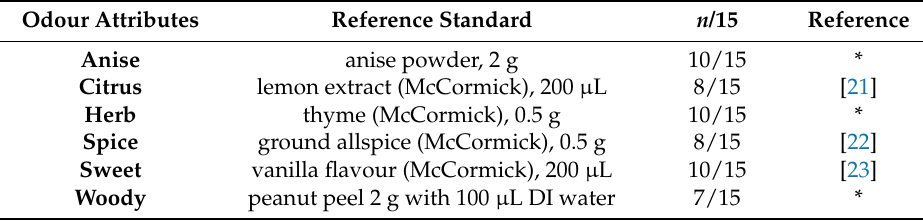
Table 1. Attributes and references used in evaluating five essential oil